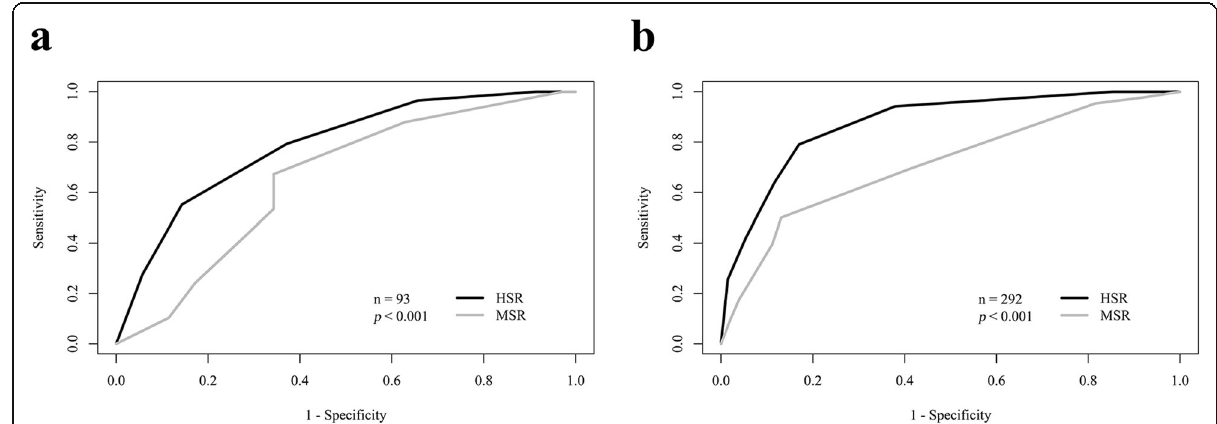
Fig. 4 All patients: receiver operating characteristic areas under the curve for comparison of MSR and HSR of myocardial competed tomography perfusion in per-patient ( a ) and per-territory analysis ( b ) using 50% diameter stenosis detected on quantitative coronary angiography as a reference standard. In all 93 patients, the area under the curve of MSR was inferior to that of HSR for both levels of analysis ( p < 0.001).